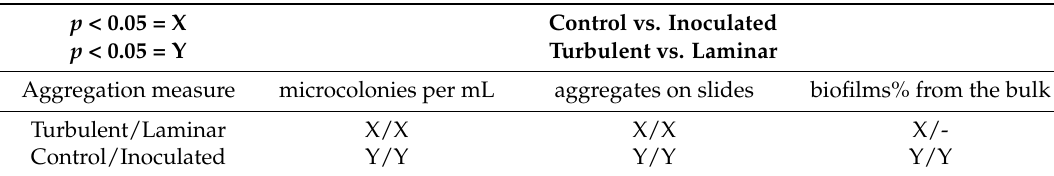
and laminar flow in the control and inoculated drinking water cultures.